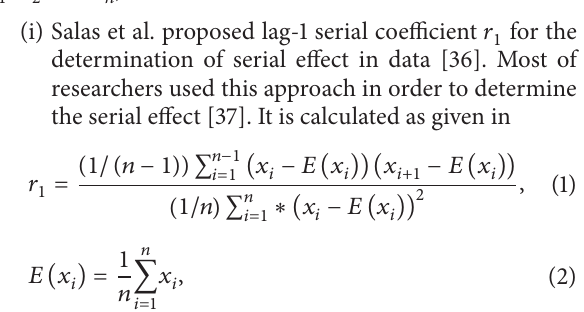
Table 1: Different seasons for analysis. Sr.